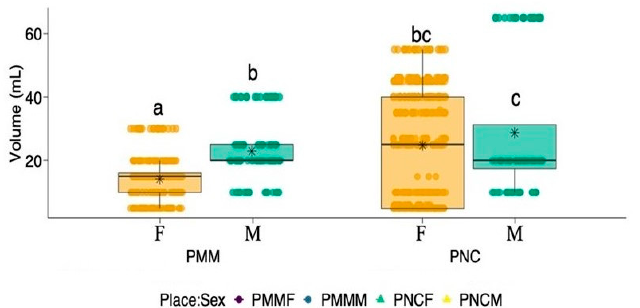
Figure 1. Variation in the fecal volume between female and male coatis ( Nasua nasua ) in two different parks, PMM (Parque Municipal Mangabeiras) and PCN (Parque Nacional do Capara ó ). Letters represent statistical differences between groups by Estimated Marginal Means. F—Female, M—Male. Boxplots are represented by first and third quartiles, median, and mean (*). PMMF, female coati from Parque Municipal Mangabeiras; PMMM, male coati from Parque Municipal Mangabeiras; PNCF, female coati from Parque Nacional do Caparaó; PNCM, male coati from Parque Nacional do Caparaó.